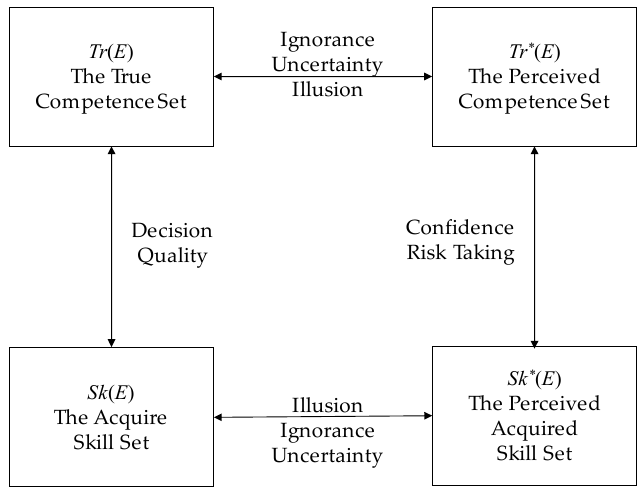
Figure 1. The interrelationships among the four elements of a competence set. Source: Shi and Yu [23].